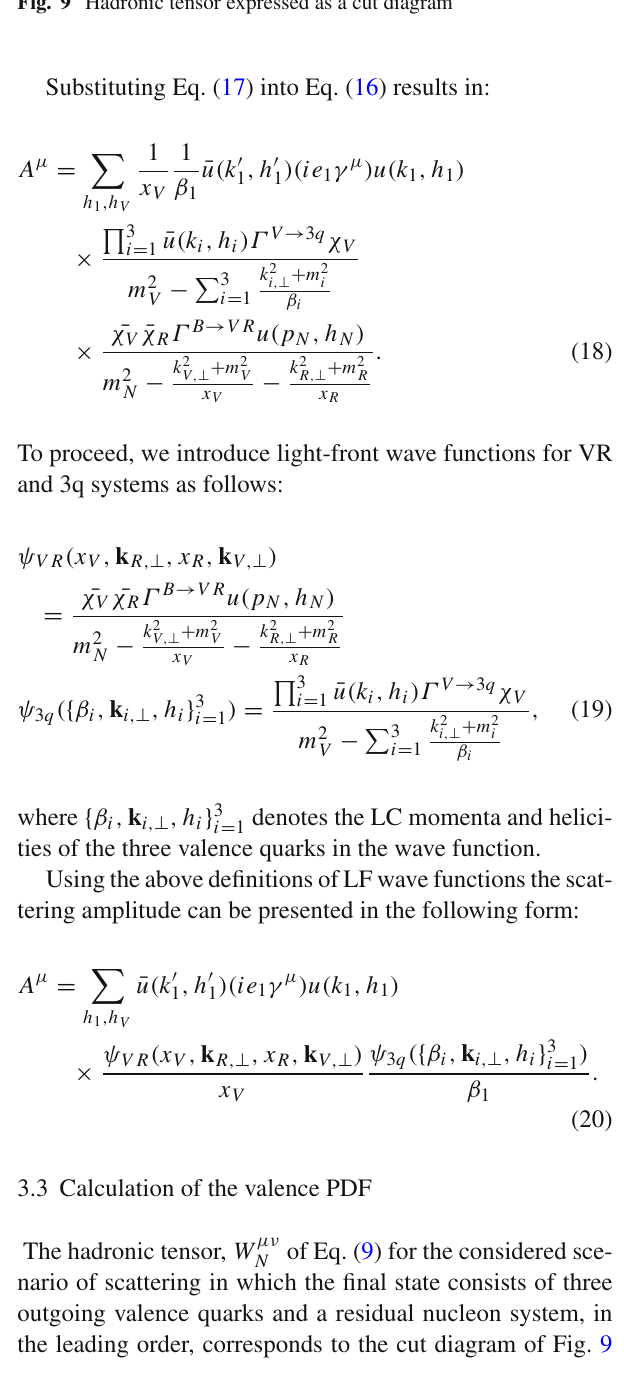
Fig. 9 Hadronic tensor expressed as a cut